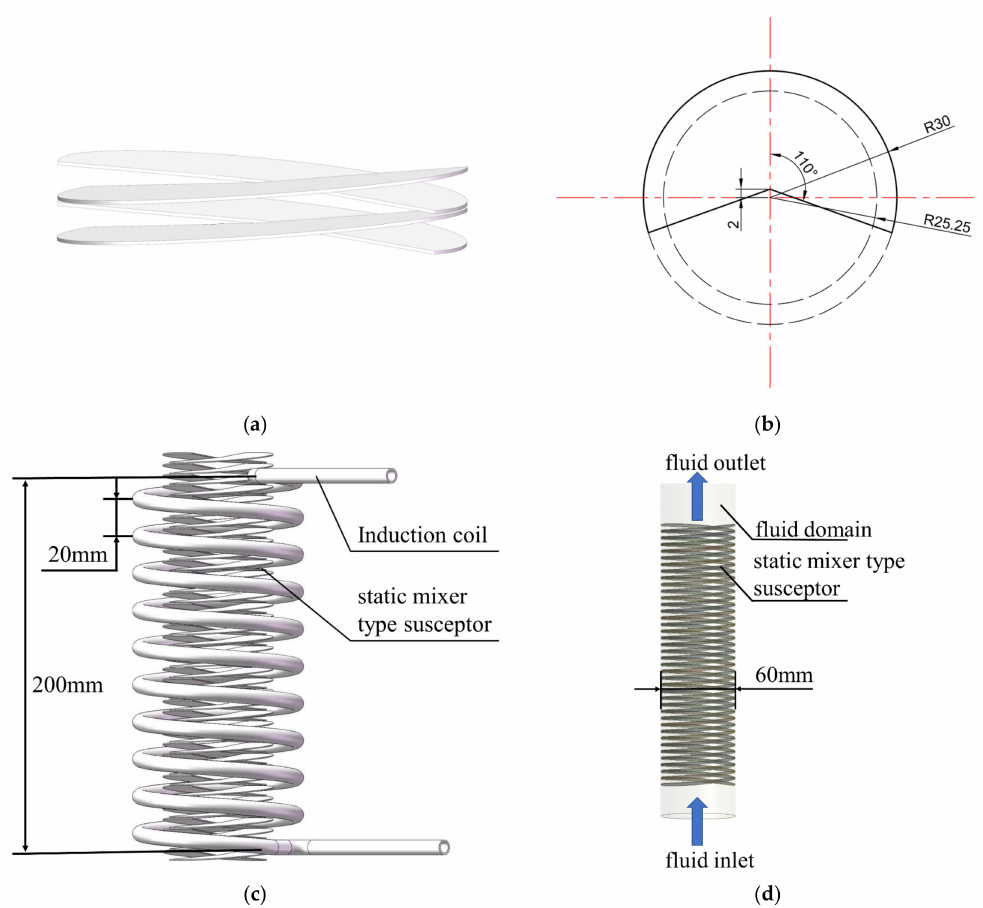
Figure 1. Modeling of susceptor, coil, and fluid domain in simulation process. ( a ) Two groups of static mixer-type susceptors with 10 ◦ inclination angle (39 groups in total). ( b ) Simplified static mixer-type susceptor structure. ( c ) Geometric model for magnetic field analysis. ( d ) Geometric model for flow field